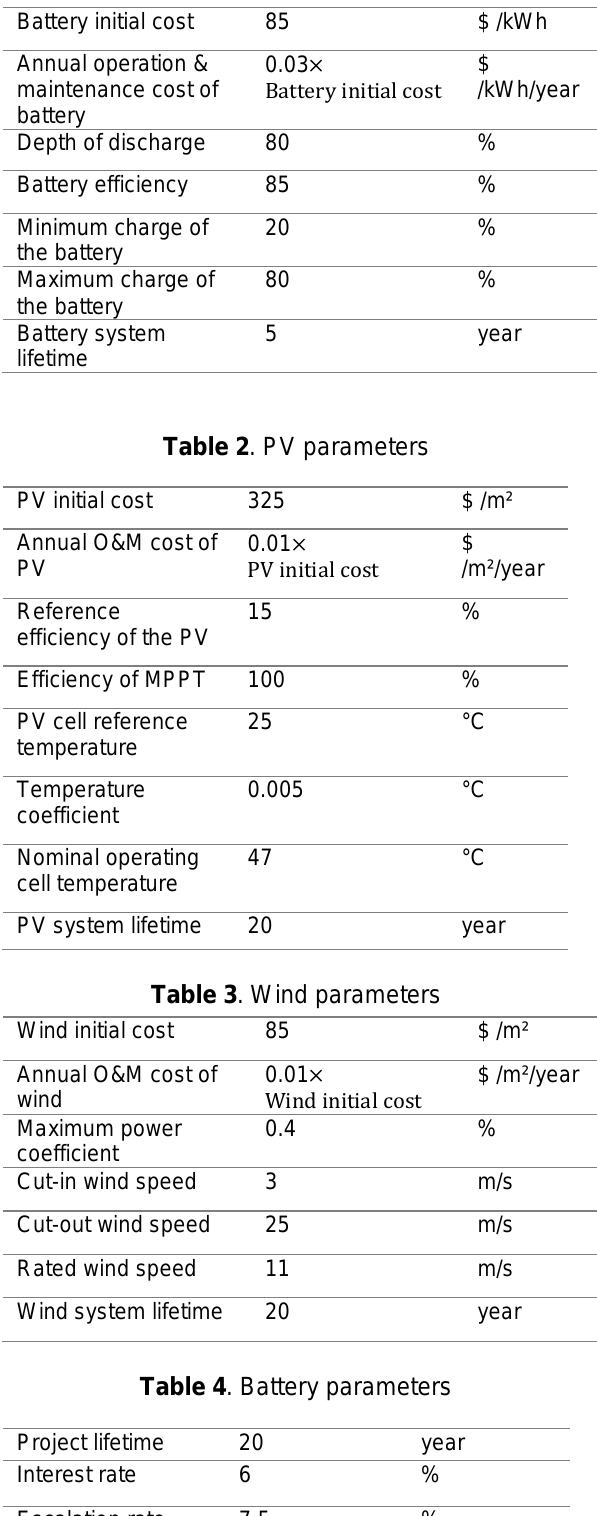
Table 1. Input parameter of economic data